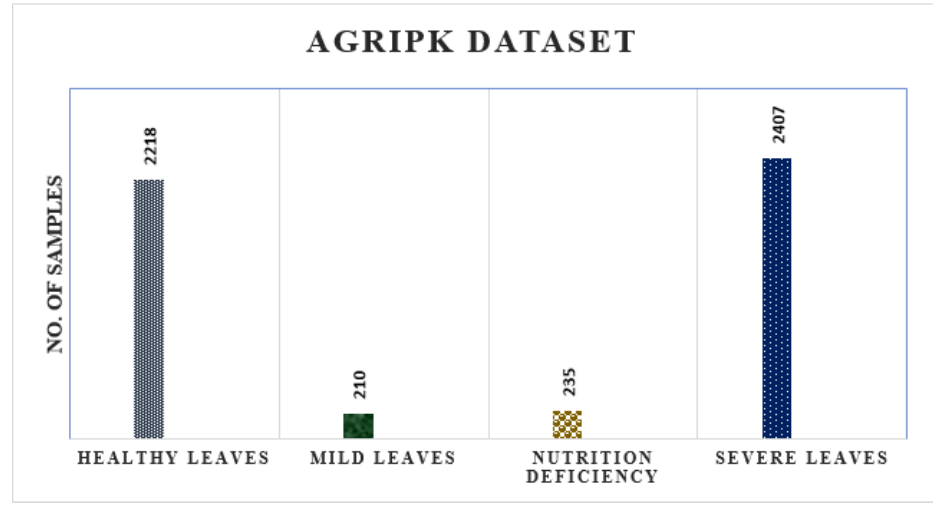
Figure 5. AgriPK sample